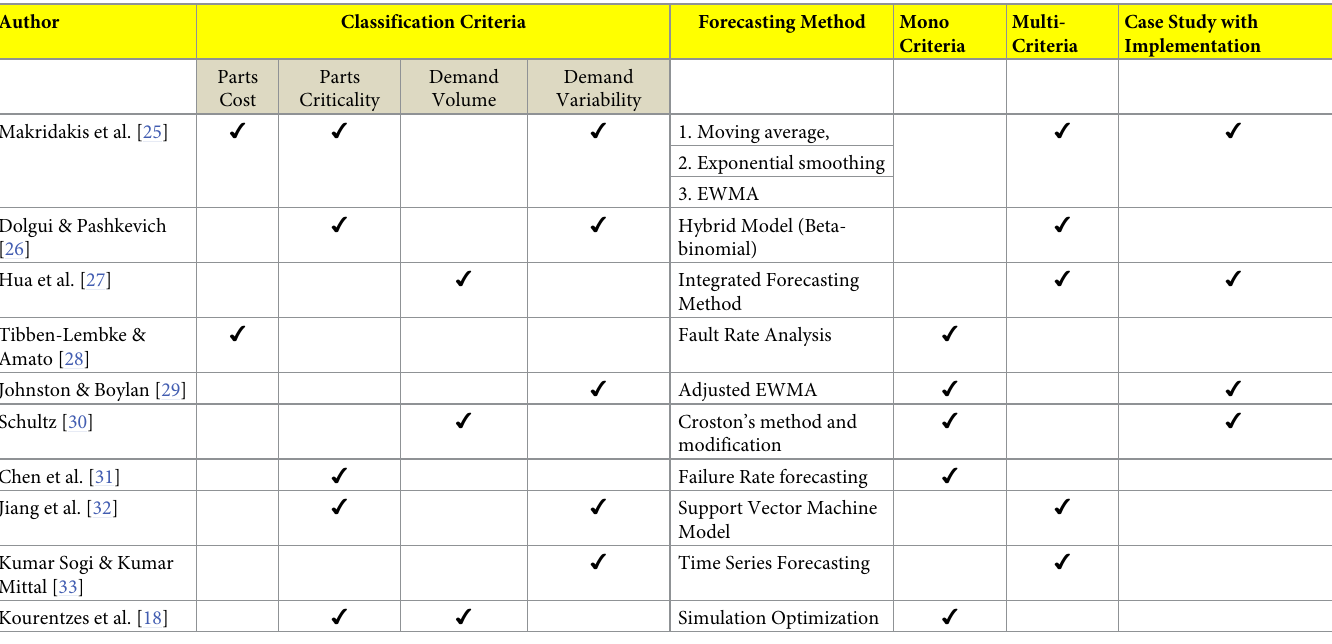
Table 1. A comparative analysis of demand forecasting